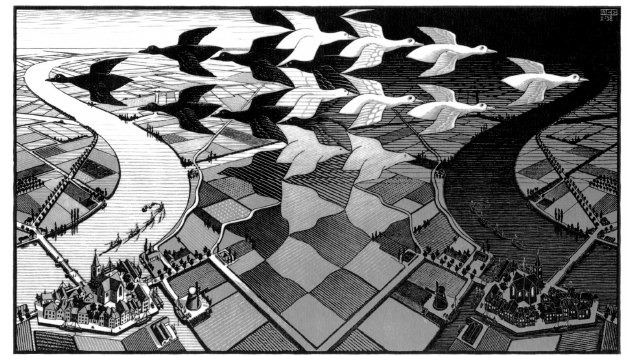
Figure 10. M. C. Escher, Day and Night , 1938.